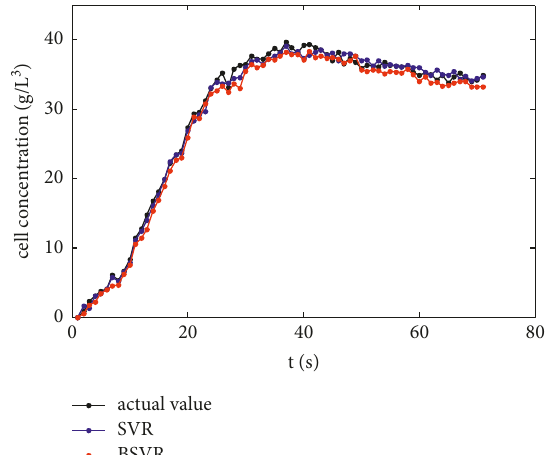
Figure 2: Curve of cell concentration